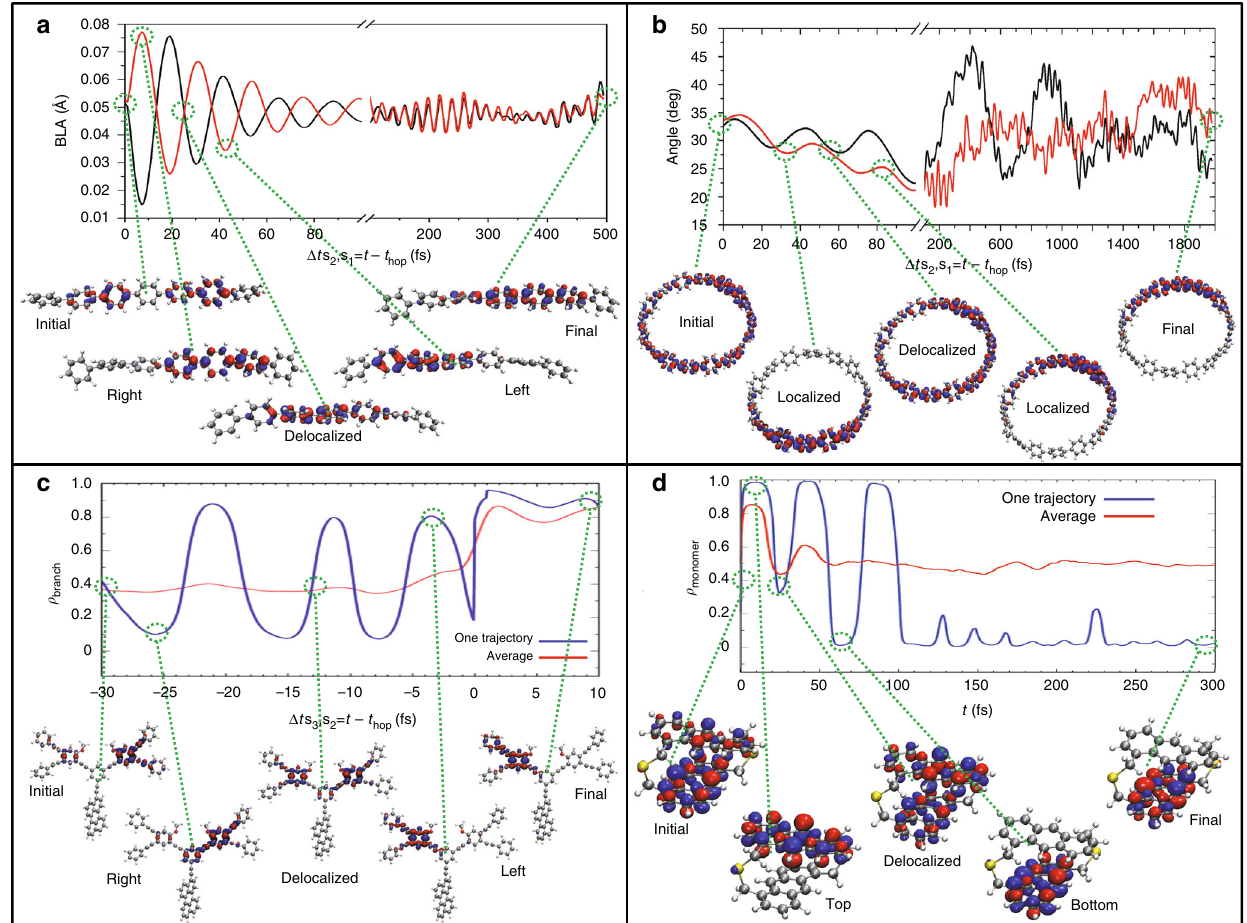
Fig. 3 Electronic and vibrational dynamics of four model systems. a – d Correspond to the Oligomer, Nanohoop, Dendrimer, and Dimer, respectively, as presented in Fig. 2. In order to synchronize the NA transitions among individual trajectories, we introduce the convenient time variable Δ t = t − t hop . The exact moment of NA transition, which varies among trajectories, is set to Δ t = 0. Negative values of Δ t correspond to times before the NA transition and positive values represent times after the transition. a The evolution of the average bond-length alternation, BLA, for the right (black) and left (red) molecular halves of the linear oligomer reveals out-of-phase oscillations corresponding to the change in localization between the two sides of the molecule con fi rmed by orbital plots of the transition density for snapshots taken during dynamics. b The evolution of the average benzene – benzene dihedral angle for the top (red) and bottom (black) molecular halves of the nanohoop indicate displacements of the ground state vibrational normal modes recovered after 200 fs. The corresponding orbital plots of the transition density for snapshots during dynamics reveal a transfer of wavefunction from bottom to top half of the nanohoop. c The evolution of the fraction of the transition density on the left branch of the dendrimer is plotted for a typical single trajectory (blue) and the ensemble average (red). The time axis denotes the time from the S 3 to S 2 transition (hop). Before the transition ( t − t hop < 0), the system on the upper state experiences oscillations between the two branches. After the transition to the lower state ( t − t hop > 0), the exciton becomes trapped in a single branch. The change in wavefunction localization is con fi rmed by orbital plots of the transition density during dynamics revealing transfer between left and right branches. d The evolution of the fraction of the transition density on the top monomer of the dendrimer is plotted for a typical single trajectory (blue) and the ensemble average (red). The oscillations correspond to the transfer between the top and bottom monomer shown in the orbital plots of the transition density taken from snapshots during